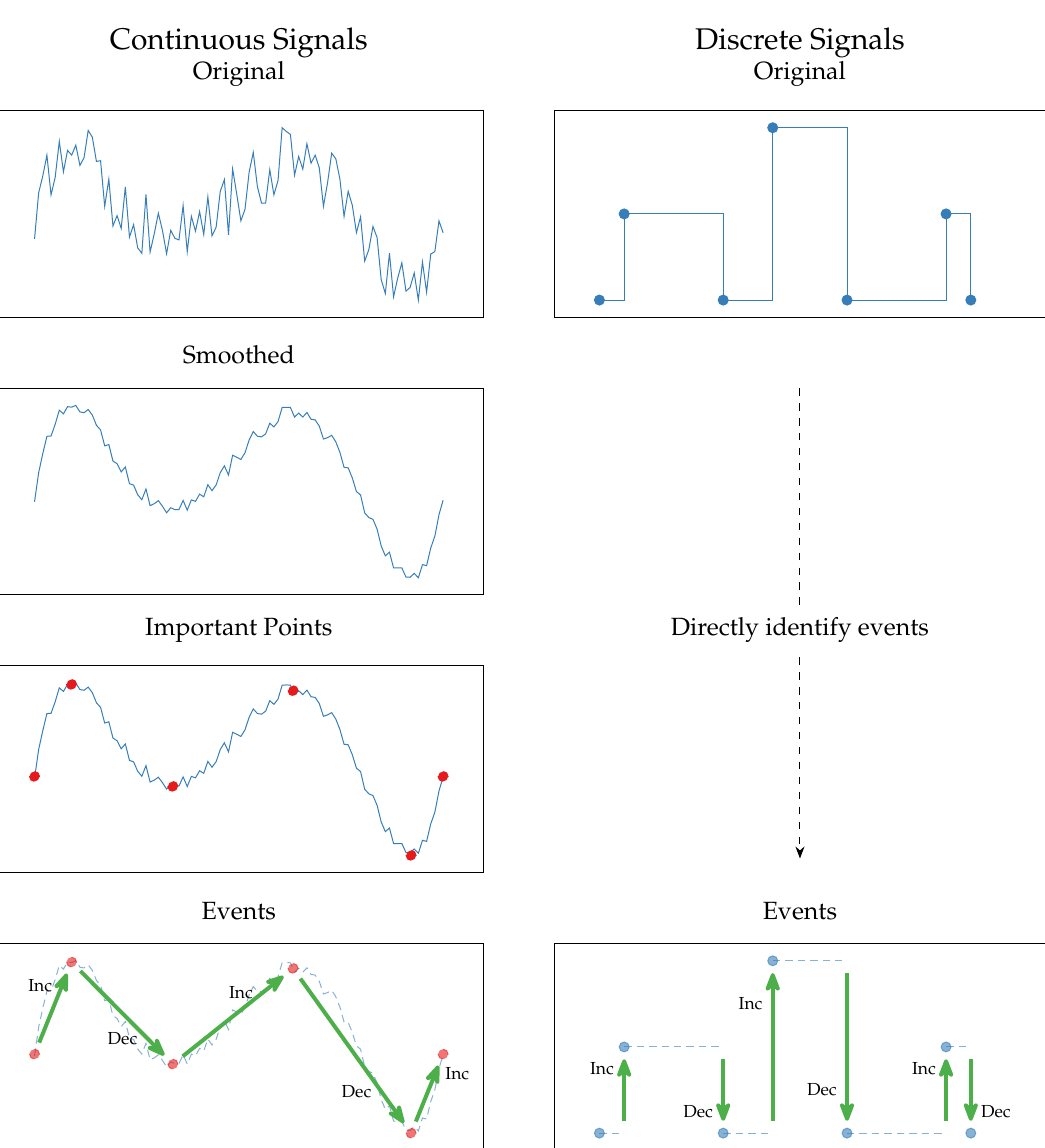
Figure 3. Extracting events from continuous and discrete time-series. Continuous time-series often present noise, therefore, they are first preprocessed with resampling, and smoothed using a lowpass filter. Important points are found in the preprocessed time-series, and events are identified from them. Discrete time-series, instead, are not affected by noise and events can be identified